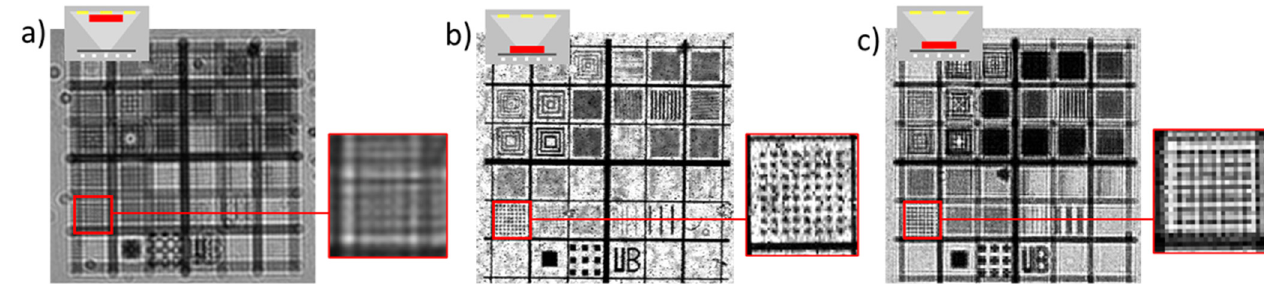
Figure 5. Images of dedicated aluminum-on-glass patterns: lensless with source 2 ( a ), and static e-STOM images with the sample dropped directly onto source 2 ( b ) or onto source 1 ( c ). In all cases the detector is 6.9 µ m in size. Insets at top left sketch the respective setups (LEDs at bottom, detectors at top and sample red colored), and enlarged areas show how 6.4- µ m squares are resolved.